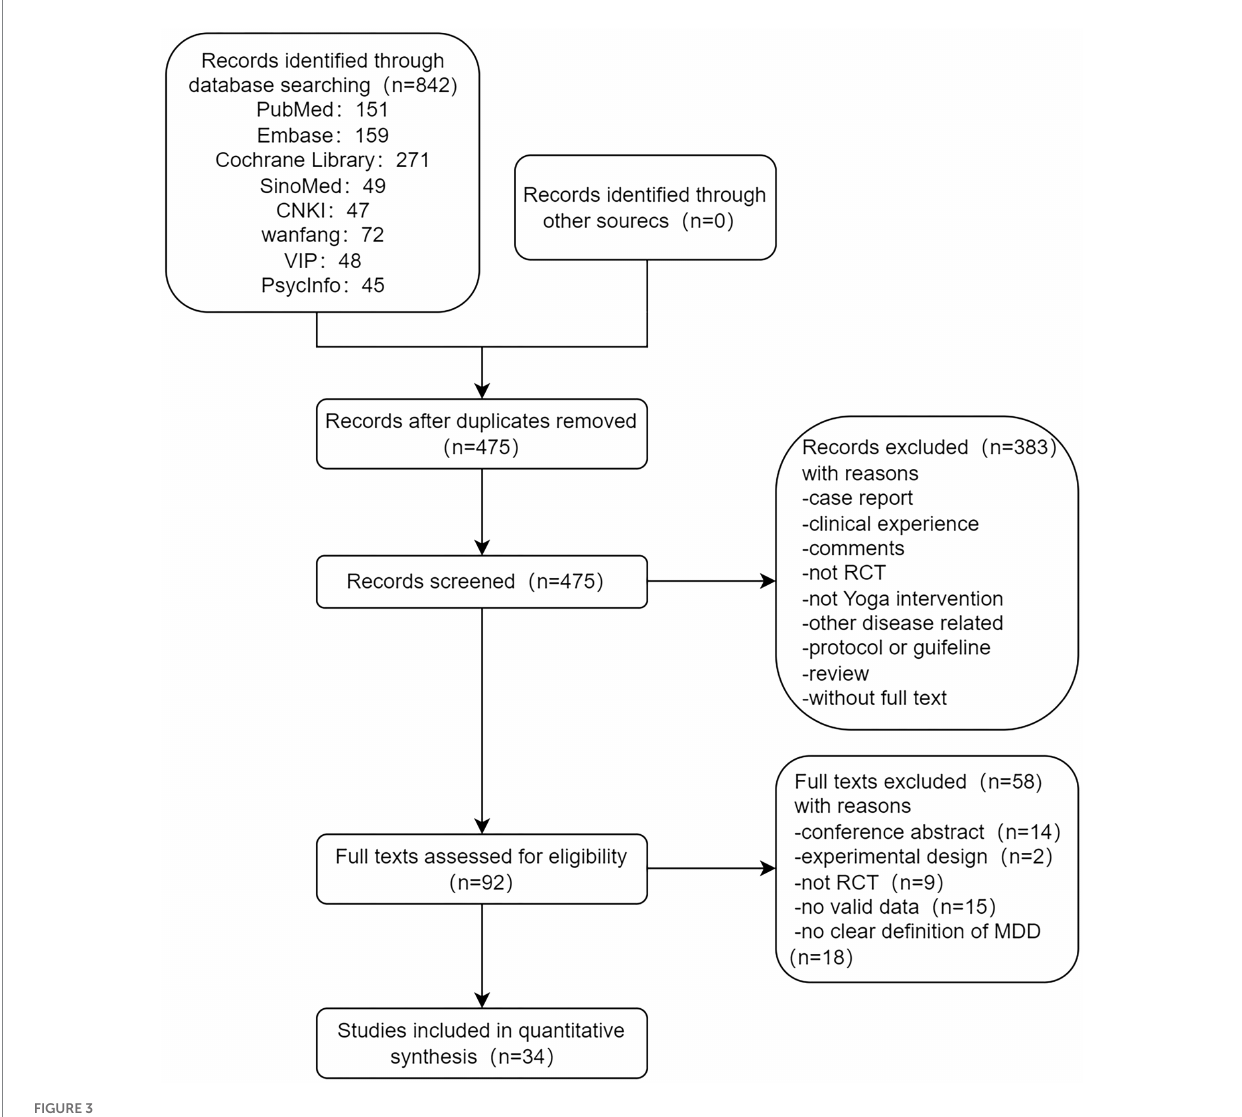
FIGURE 3 Literature screening